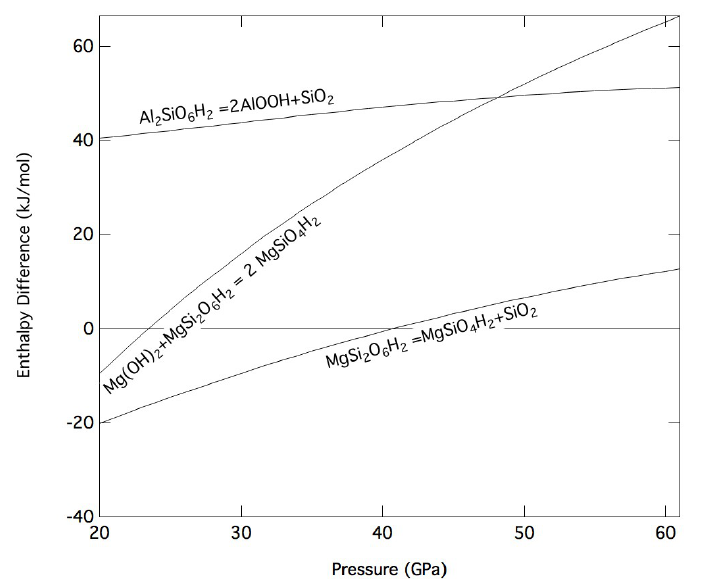
Figure 5. Static (0 K) excess enthalpy difference for the breakdown of phase D to phase H with ideal, end-member